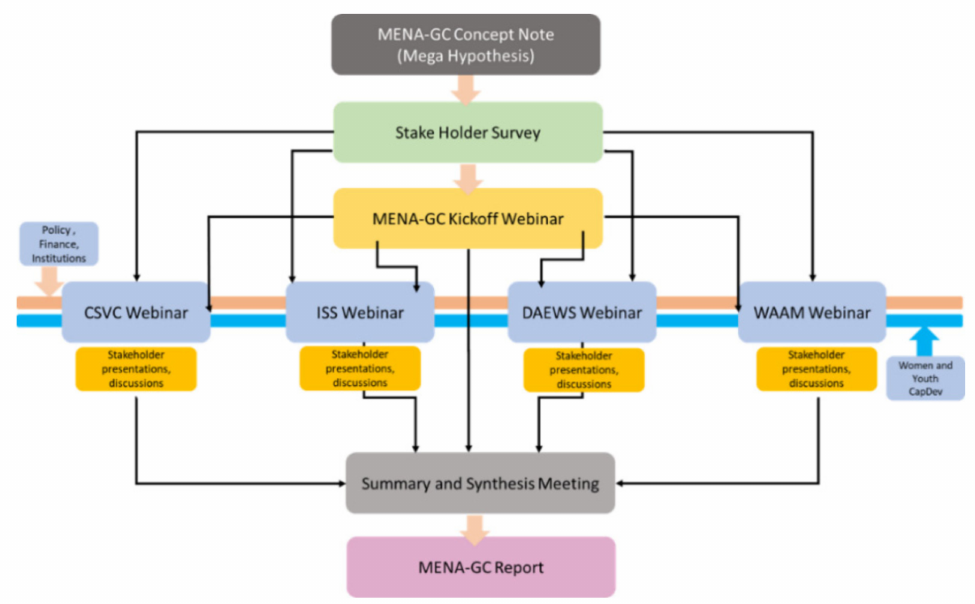
Figure 3. An illustration of the MENA-GC stakeholder consultation process to synthesize a “demand- driven” research agenda that could well capture the perspectives of a diverse stakeholder